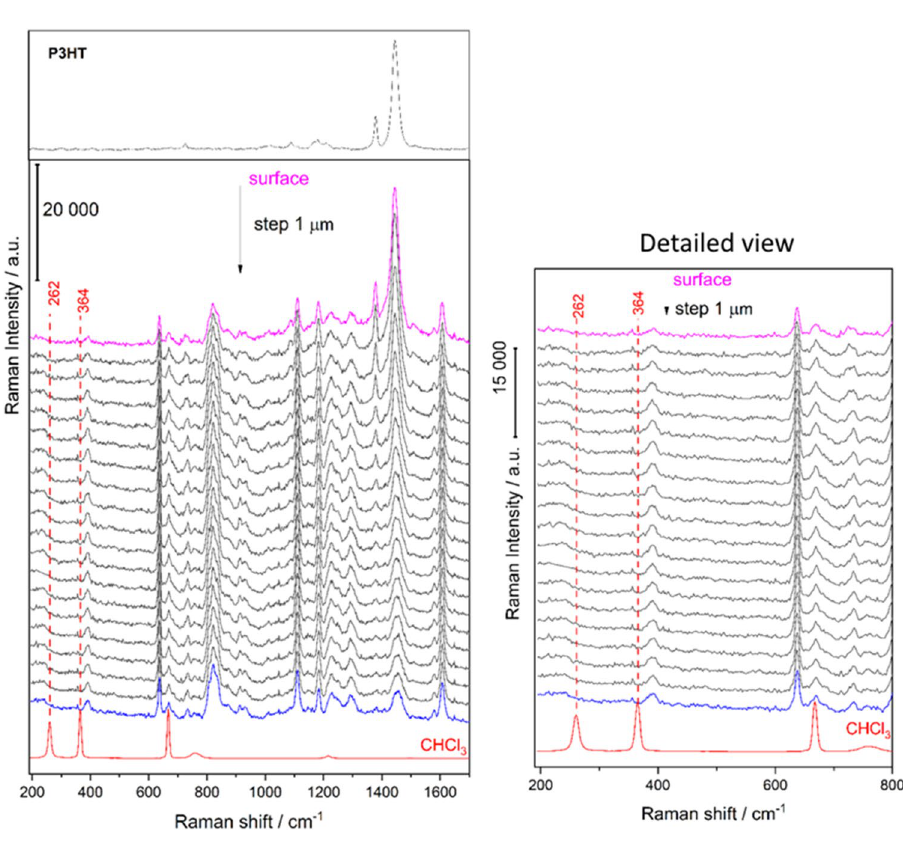
Figure 8. Raman spectroscopy